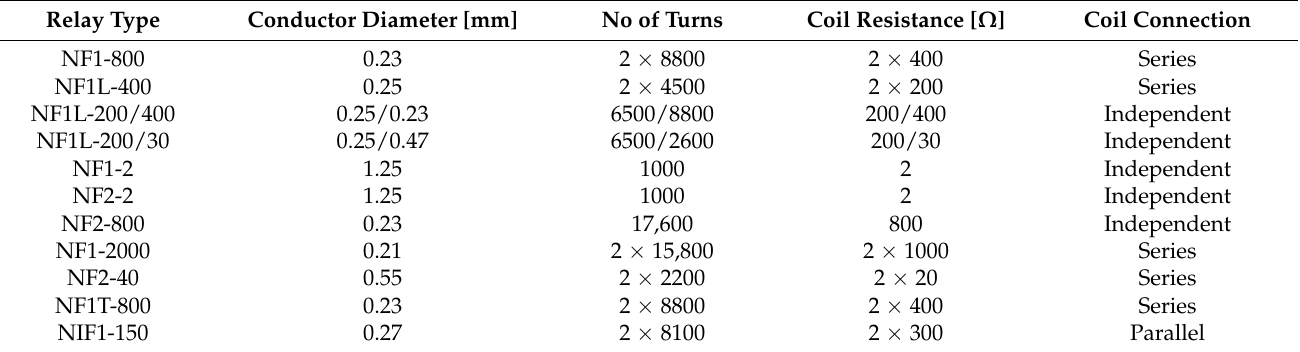
Table 1. Main characteristics of N relays.